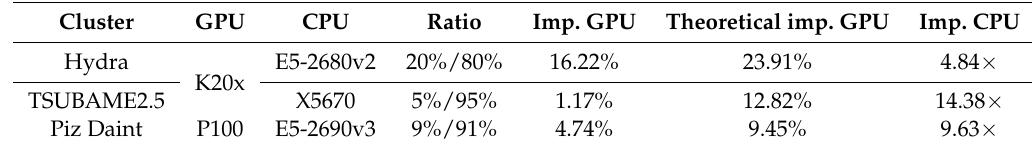
Table 3. Performance improvement by using a heterogeneous system instead of a homogeneous one. Experiments are carried out for a 512 × 512 × 128 domain using double precision. Column “ratio” lists the best performing CPU/GPU ratio. All CPUs are Intel Xeons, all GPUs NVIDIA Teslas. Imp. stands for improvement. Values in the columns “imp. GPU” and “imp. CPU” list the measured relative performance improvement of the heterogeneous version compared to the particular computing devices in percent (%) or whole factors ( × ) where appropriate. The theoretical improvement in comparison to the GPU-only configuration is given in the corresponding